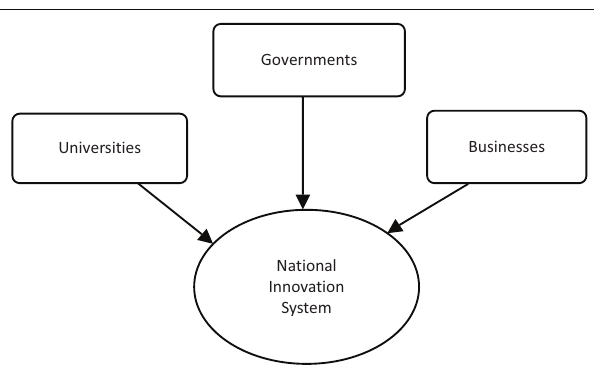
FIGURE 8: Disaggregated components of the national innovation